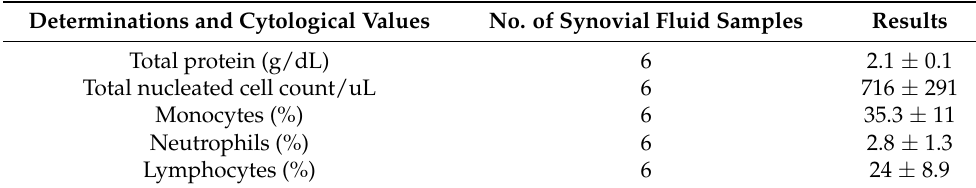
Table 1. Results of examination of synovial fluid from normal horses. Determinations and Cytological Values No. of Synovial Fluid Samples Results Total protein (g/dL) 6 Total nucleated cell